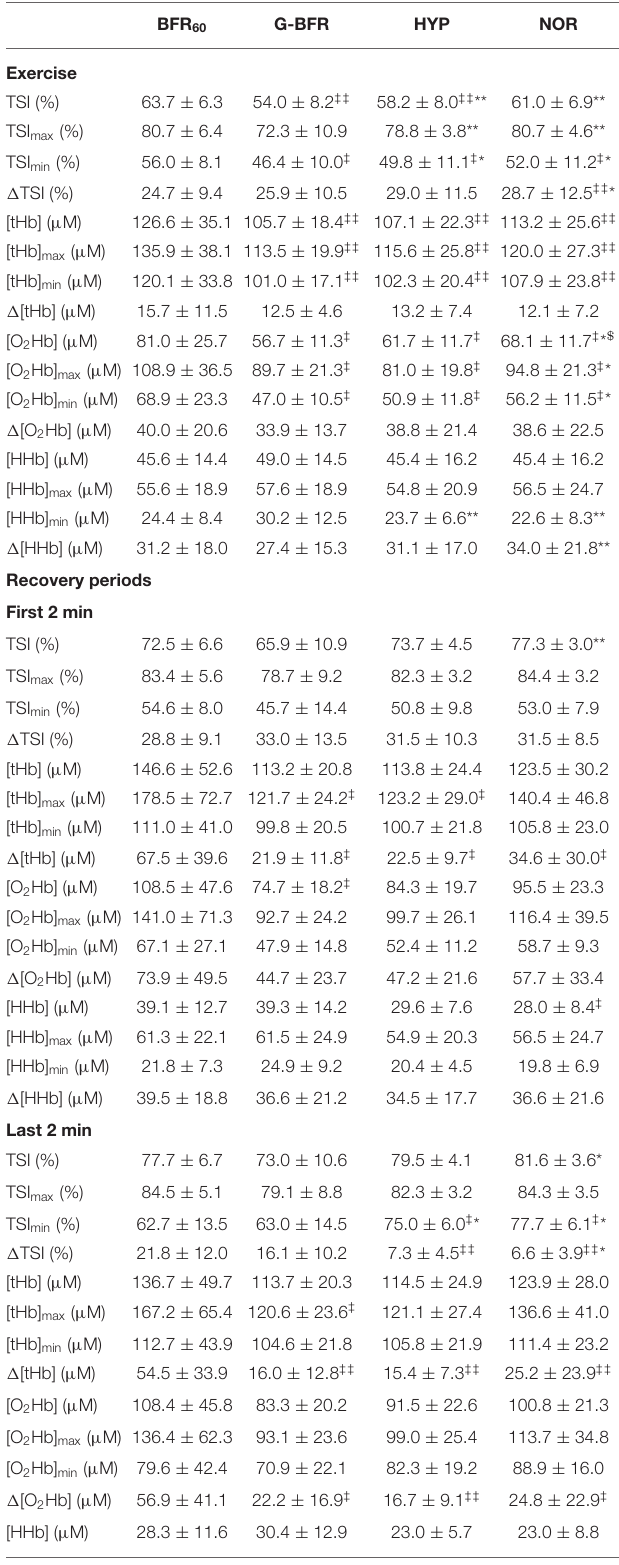
TABLE 2 | Near-infrared spectroscopy (NIRS) parameters during the interventions.